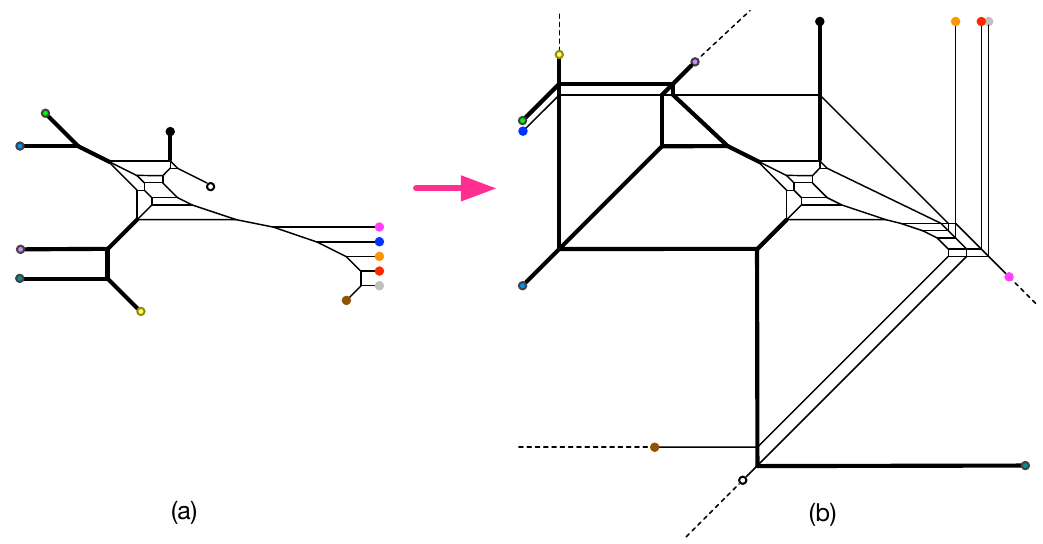
Figure 23 . A SU(6) 3 + 1 TAS + 1 AS + 8 F Tao diagram. The number of 5-branes attached to 2 2 a 7-brane can be read o(cid:11) by tracking the number of Hanany-Witten transitions taking place in (cid:12)gure (b).